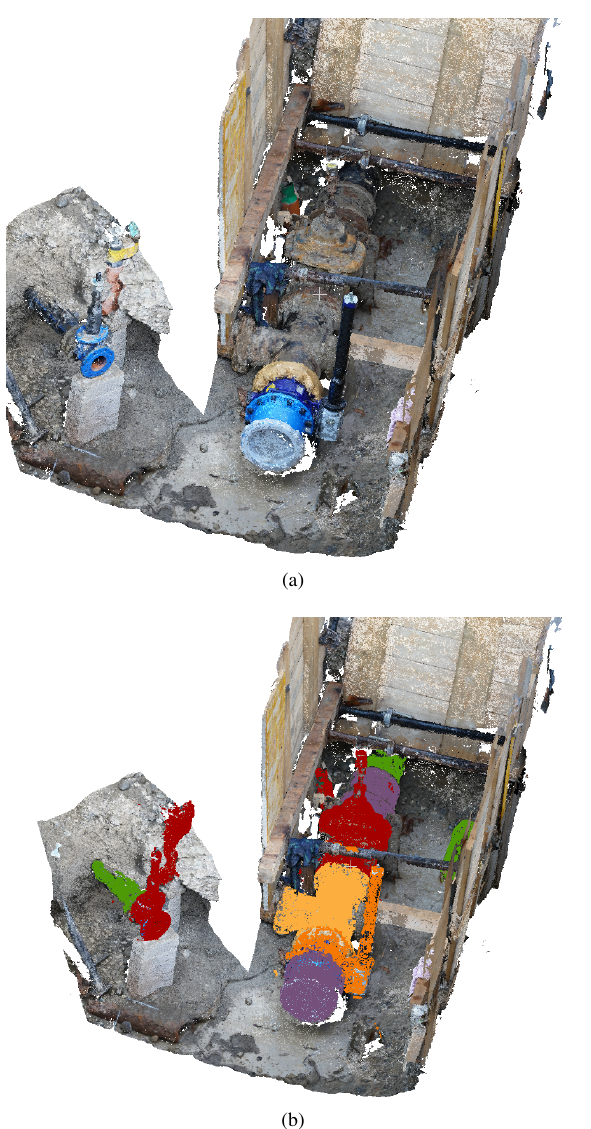
Figure 9: (a) Raw point cloud and (b) point cloud segmented by class overlaid on the raw point cloud.